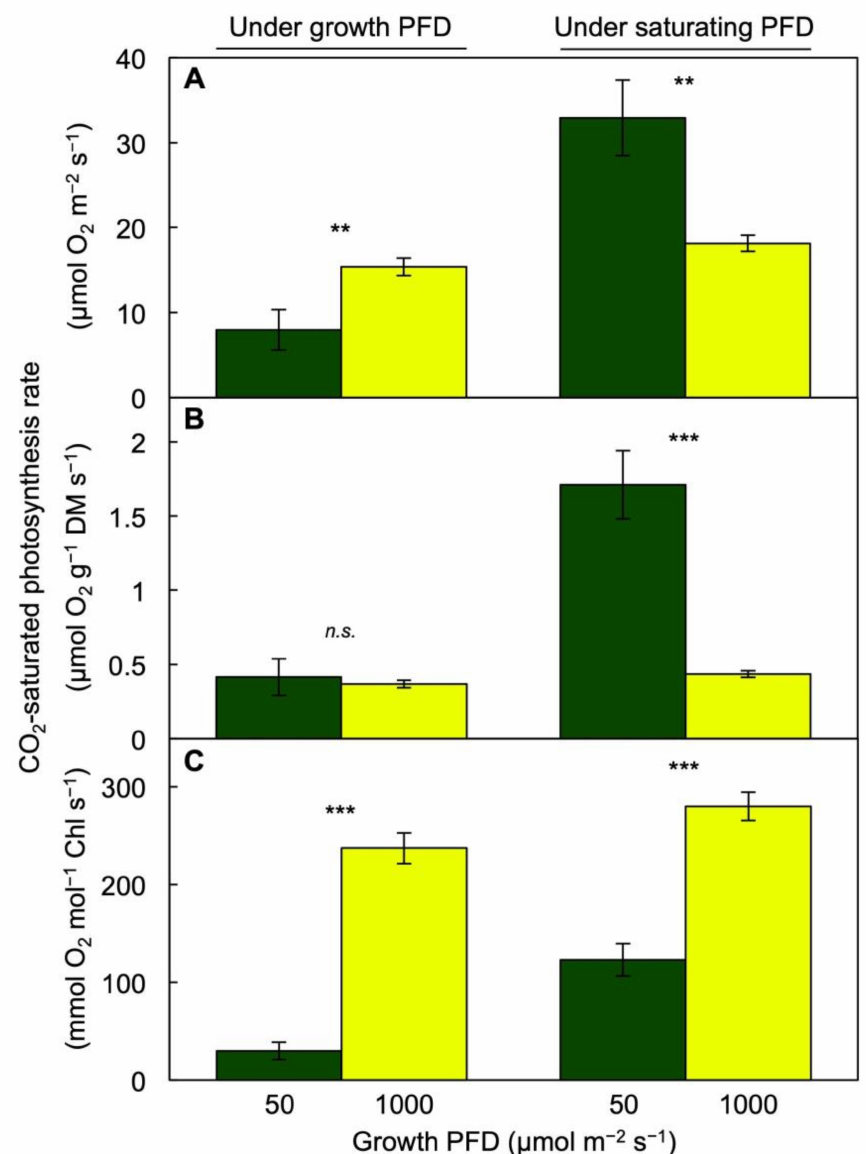
Figure 3. CO 2 -saturated rates of photosynthetic oxygen evolution of fronds on the bases of ( A ) area, ( B ) dry mass (DM), and ( C ) chlorophyll (Chl) a + b levels from Lemna gibba plants grown under PFDs of 50 (green) or 1000 (yellow) µ mol m − 2 s − 1 and measured under the respective growth PFDs (left columns) as well as a common saturating PFD of 1500 µ mol m − 2 s − 1 (right columns). Mean values ± standard deviations; n = 3. Significant differences between growth PFDs are denoted by asterisks; ** = p < 0.01, *** = p < 0.001, n.s. = not significantly